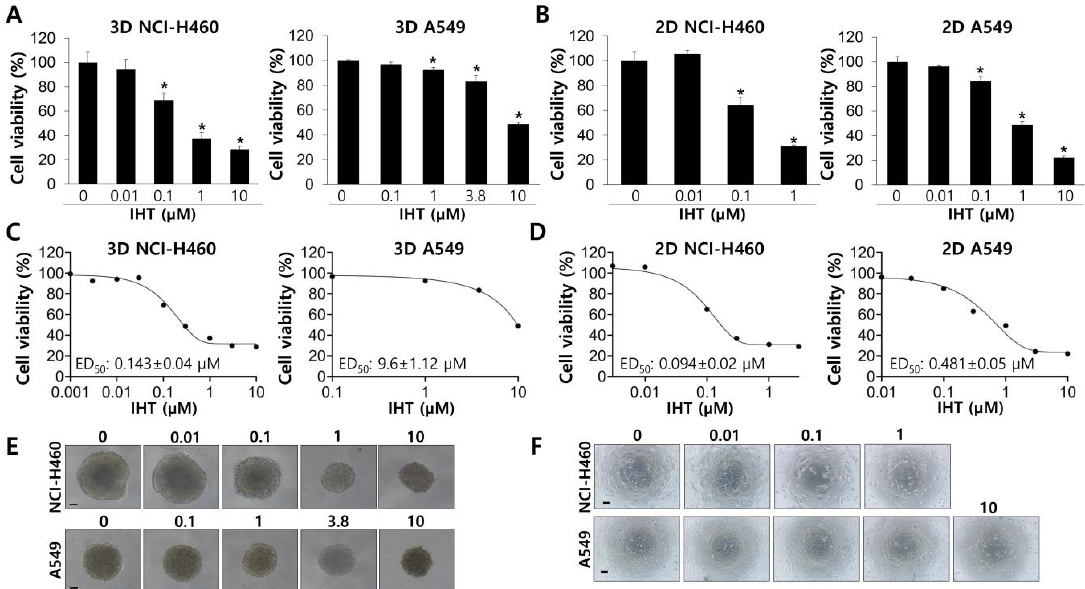
Figure 2. Isoharringtonine (IHT) inhibits the growth of non-small cell lung cancer (NSCLC) cells in 2D and 3D culture systems. ( A ) A549 and NCI-H460 cells were seeded in ULA plates and grown for 2 days before IHT treatment with the indicated concentrations. After 72 h, cell viability was measured by the CellTiter-Glo 3D cell viability assay kit. *, significantly different from control ( p < 0.05). ( B ) 2D-cultured cells were exposed to IHT at the indicated concentrations for 48 h, and cell viability was examined by the CellTiter-Glo assay. *, significantly different from control ( p < 0.05). ( C , D ) The median effective dose (ED 50 ) values of IHT were obtained from dose-response curves generated by GraphPad Prism. ( E , F ) Representative images were collected before viability assay. Scale bars, 100 μm. All data are presented as mean ± SD.